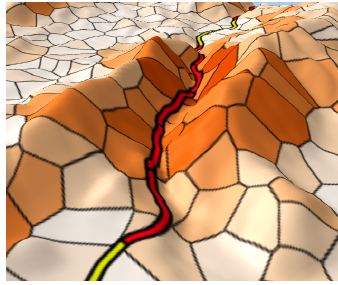
Figure 17. 3D rendering of the segments of Figure